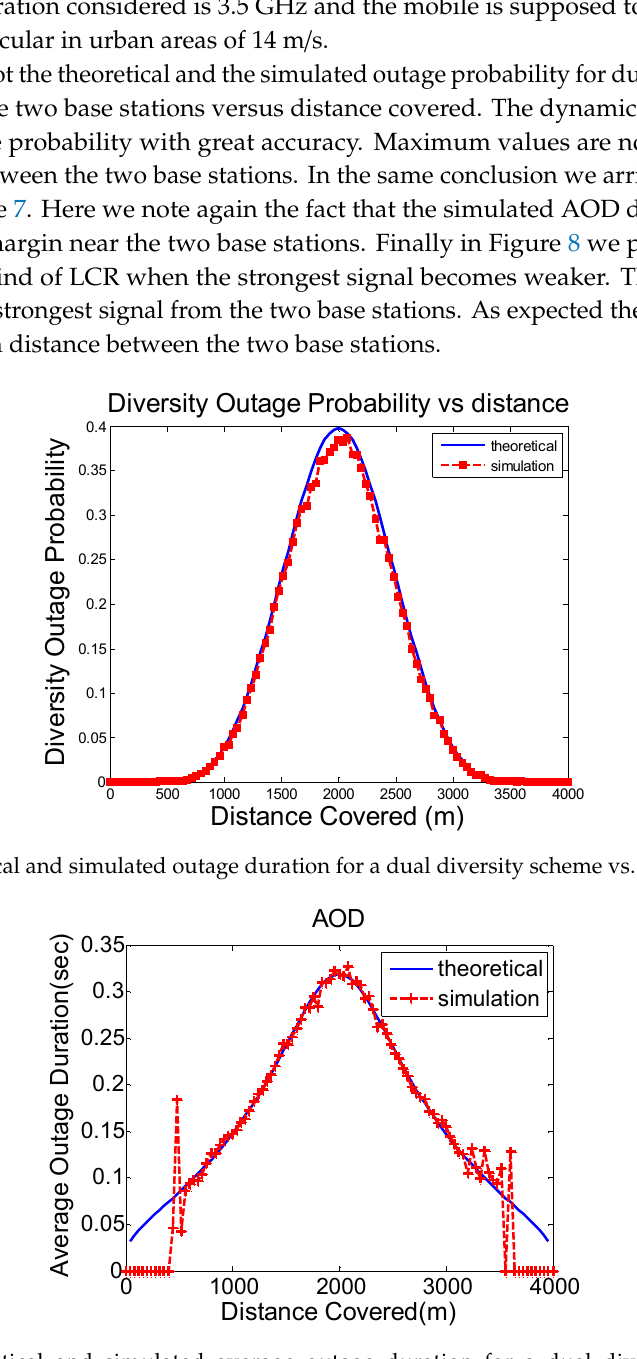
Figure 8. Average hand-off rate for a mobile receiver moving between two base stations. 4. Conclusions In this paper, there has been presented a novel dynamic model, able to take into account the fluctuations of shadowing in a statistical basis. The main assumption of the modeling as validated from experimental results is the joint lognormality of the related shadowing values. The new dynamic channel model framework may be used for the effective and realistic design of new wireless systems by providing simulated time series for testing, as well as in the implementation of fade mitigation techniques. The model can effectively be used in the accurate design and analysis of modern wireless systems including 5G cellular wireless systems, MIMO systems, diversity (transmit, reception, cooperative) schemes, ad-hoc networks, multi-hop wireless, collaborative cognitive radios, body area networks, and in every other aspect of wireless networking, where correlated shadowing has a major impact on system’s performance. The proposed model can also be incorporated in transitions state models LOS/NLOS (blockage or not) state transition modeled as a Markov chain. Moreover, with a view not referring to specific equipment characteristics, the numerical results have been presented in relation to the fade margin. Author Contributions : All authors contributed extensively to the work presented in this paper. G.A.K. had the original idea on which we have based our current work and had the overall coordination in the writing of the article. A.D.P. was responsible for the overall orchestration of the performance evaluation work. Both authors have contributed to the writing of the article. Acknowledgments: The NTUA-ELKE 95005700 Research Fund has supported the work of A.D.P.